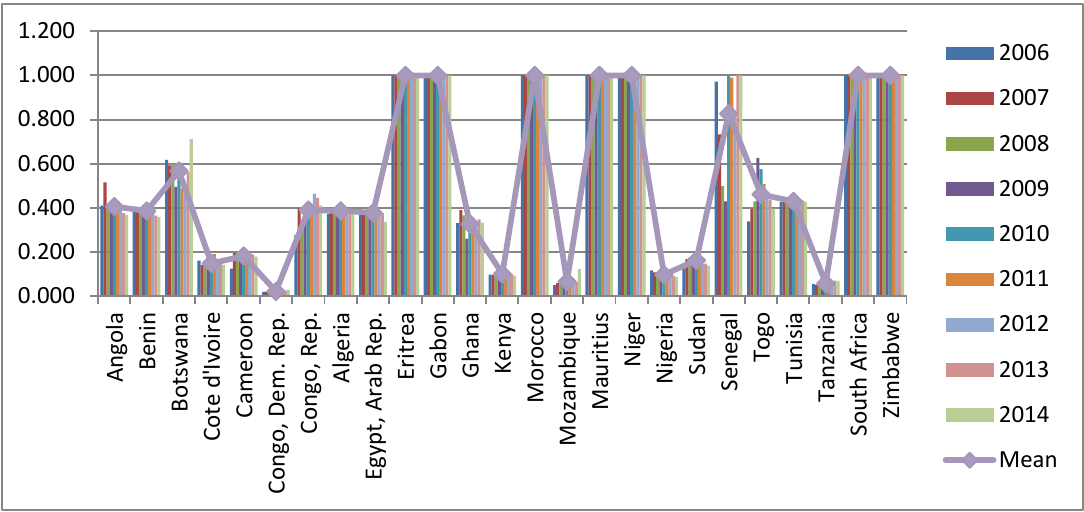
Figure 3. Energy e ffi ciency estimates from dynamic slack-based models (DSBM) with Figure 3. Energy efficiency estimates from dynamic slack-based models (DSBM) with carbon.